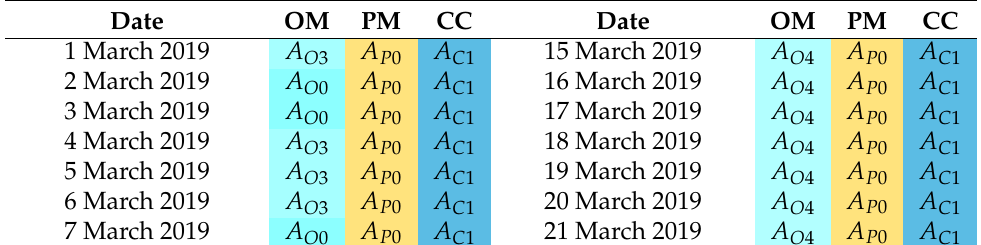
Table 6. Patterns representing the behavior of heating system between 1 to 7 March 2019 and 15 to 21 March 2019.